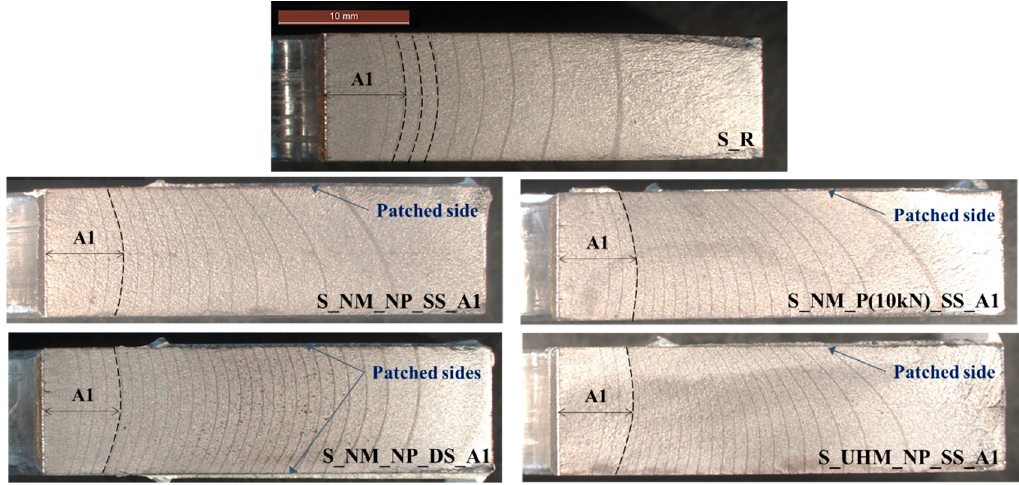
Figure 2. “Beach marks” obtained for both un-strengthened and strengthened S235 carbon steel specimens with different reinforcement configurations.